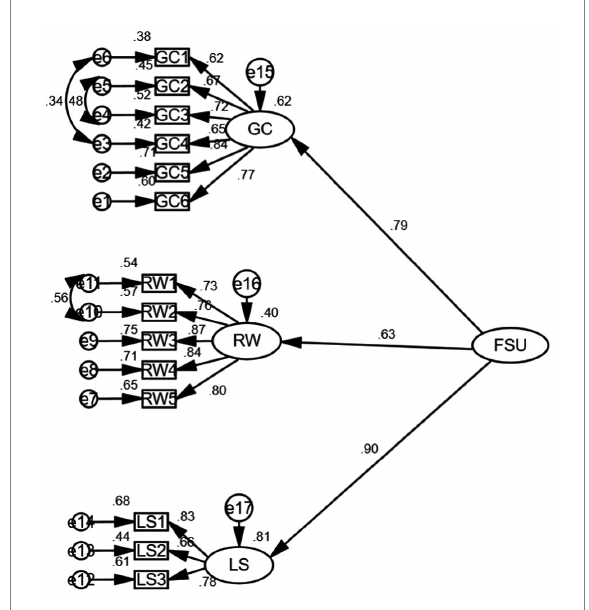
FIGURE 2 The second-order factor result of the favorable Smartphone usage scale (Note: FSU, favorable Smartphone usage; GC, general contribution; RW, reading and writing; LS, listening and speaking).